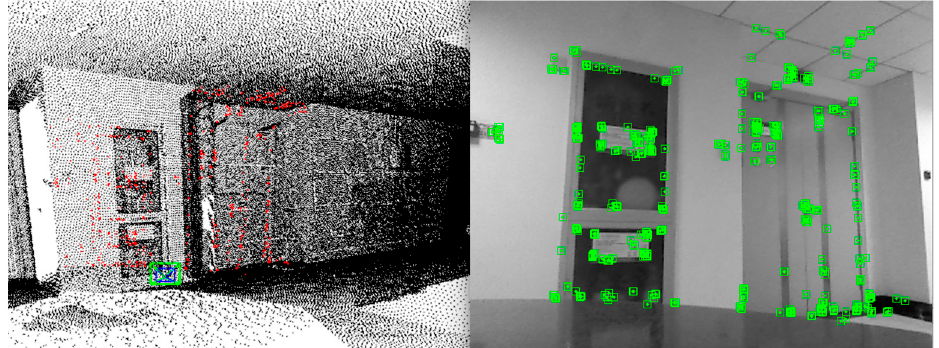
Figure 6. Successful initialization by matching the RGB-D and LiDAR scenes by ICP with initial value from deep learning.